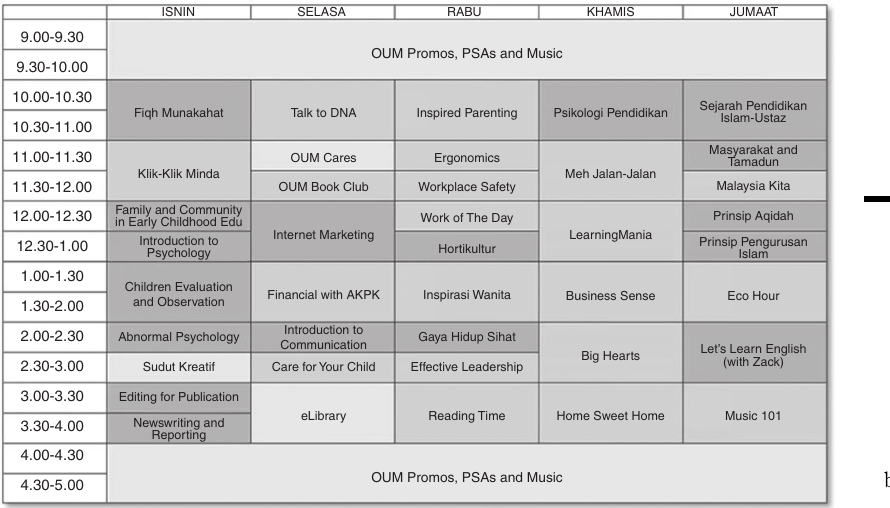
Figure 1. January